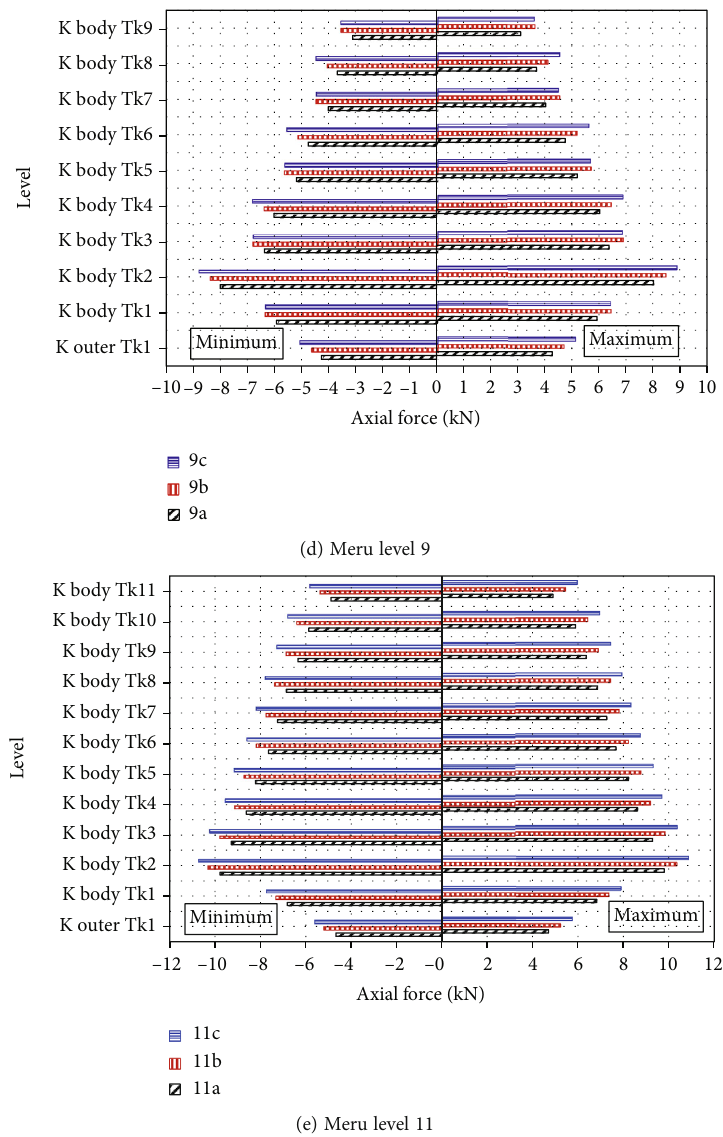
Figure 10: Column maximum axial force due to earthquake load direction X for Meru levels 3, 5, 7, 9, and